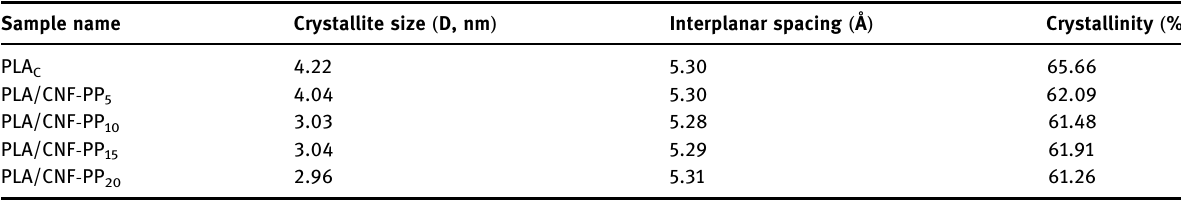
Table 2: XRD analysis data of PLA sca ff olds with di ff erent CNF